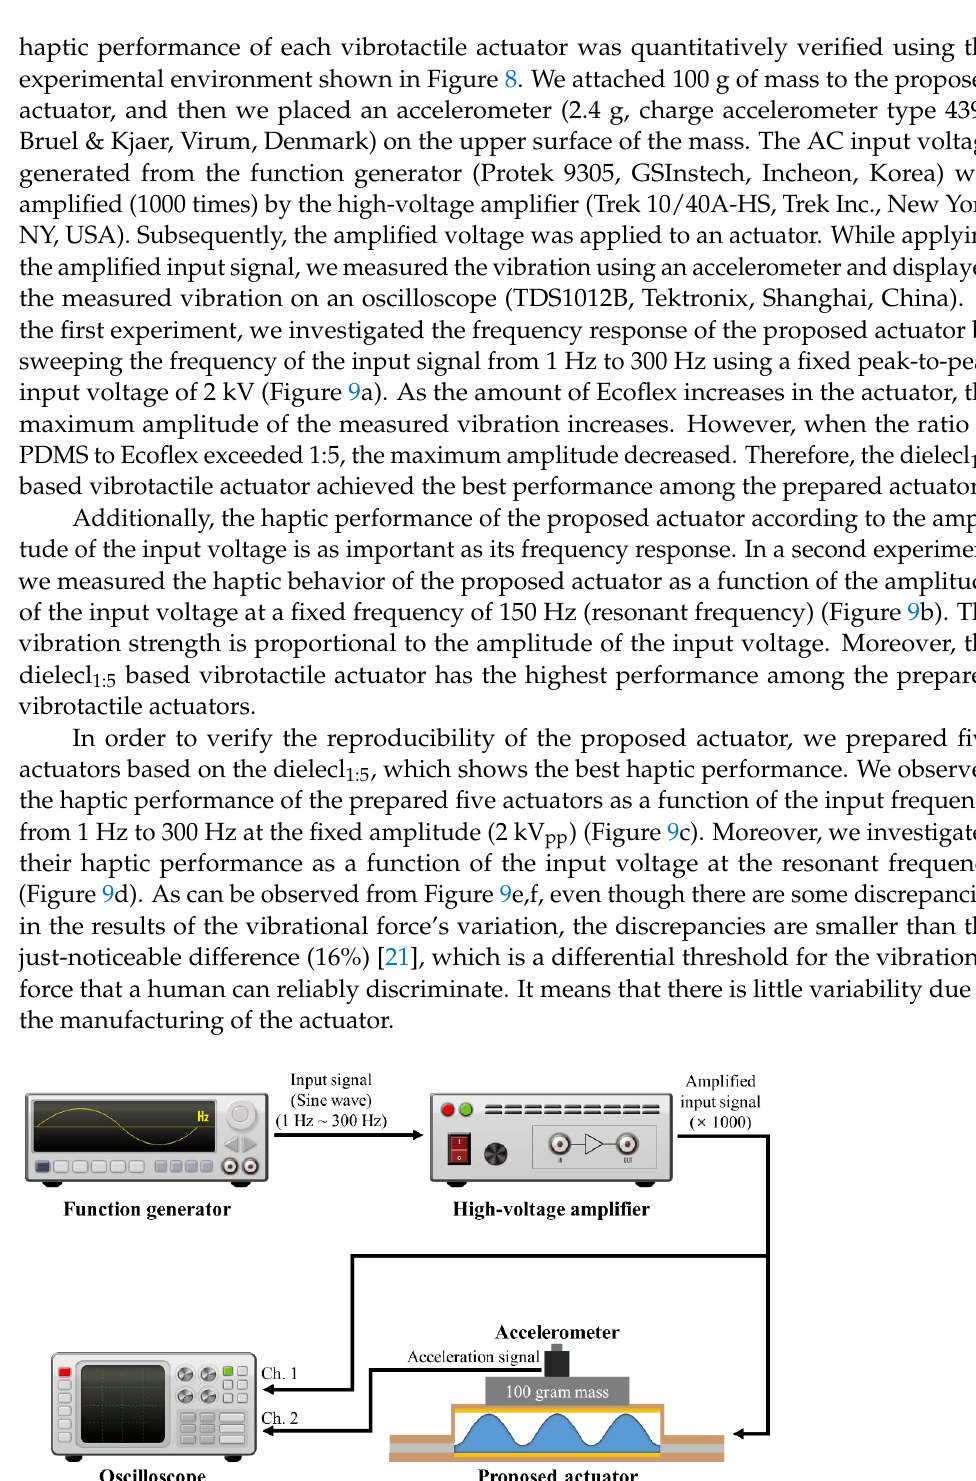
Figure 7. Dielectric properties of the dielectric layer samples.